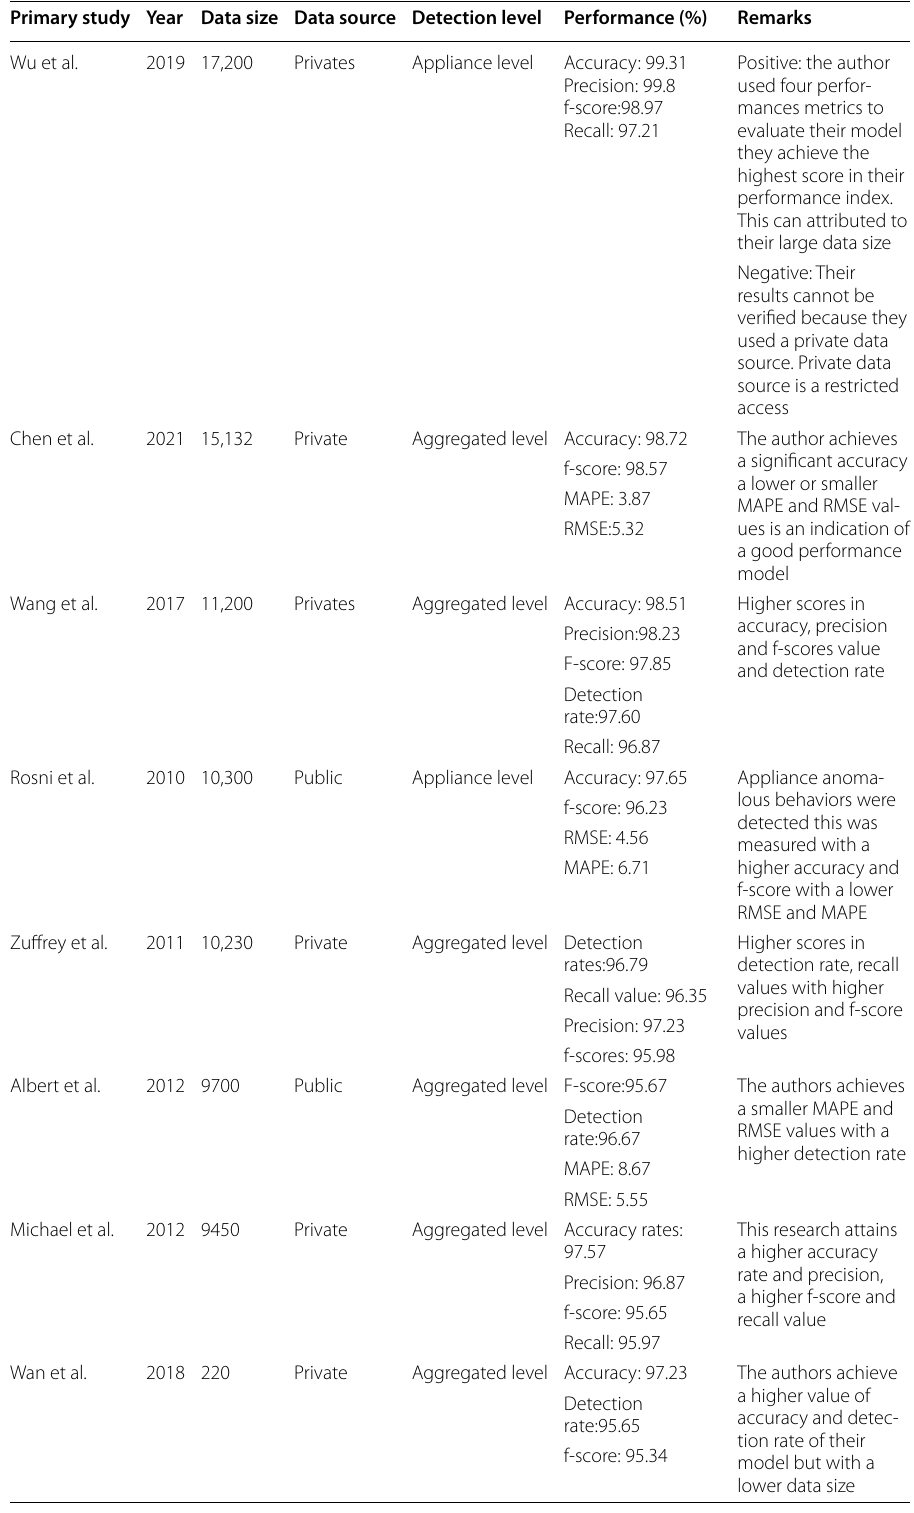
Table 4 Top studies analysis Primary study Year Data size Data source Detection level Performance